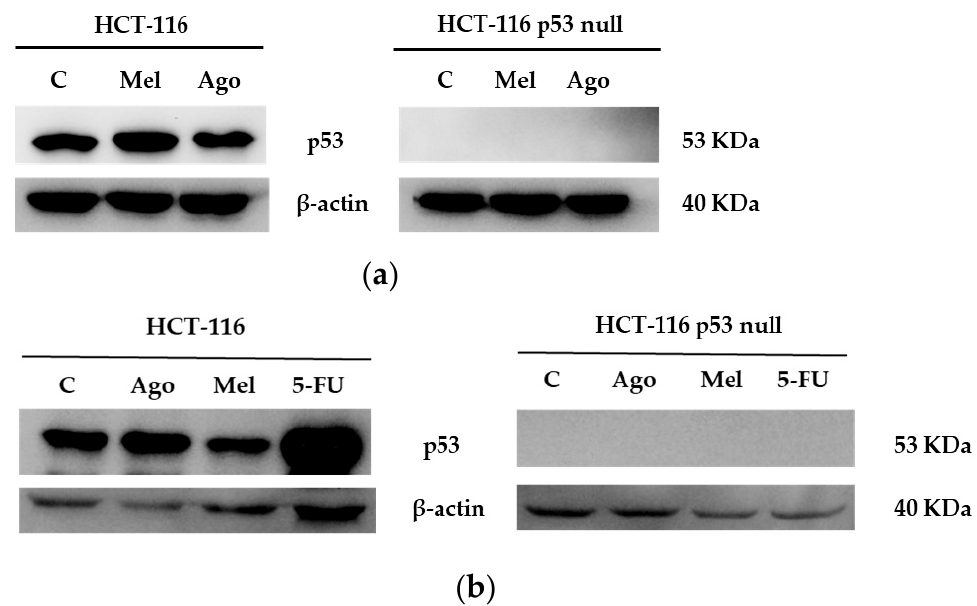
Figure 5. Expression levels of p53-protein in response to the treatments ( a ) with 0.5 mM agomelatine (Ago) and 1 mM melatonin (Mel) in the in vitro model, and ( b ) with agomelatine (Ago), melatonin (Mel), and 5-5-fluorouracil (FU) in tumors derived from HCT-116 and HCT-116-p53-null cell lines.